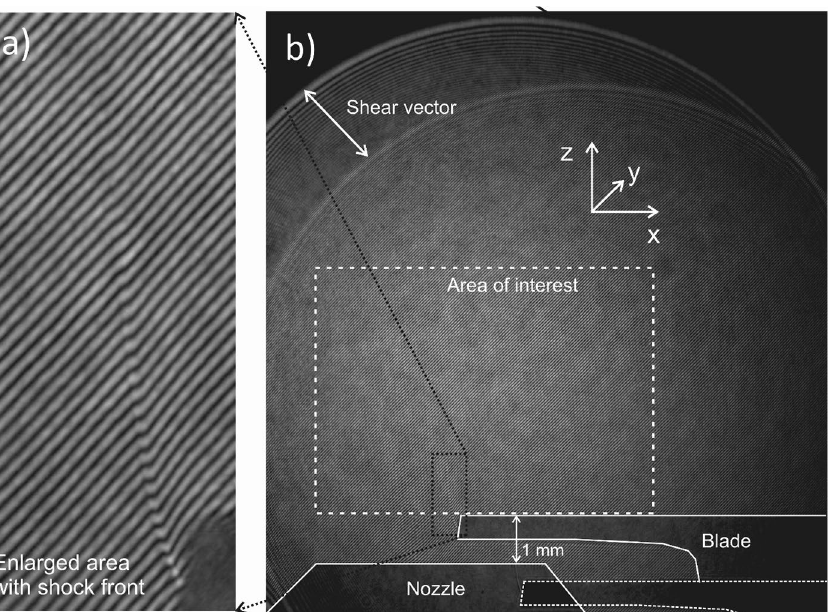
Figure 6. ( a ) Part of the raw interferogram with bent fringes due to the shock front from the blade. ( b ) Raw interferogram with schematics showing the positions of the nozzle and the